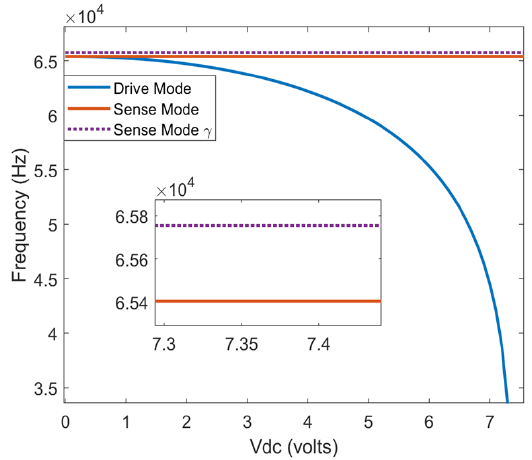
Figure 3. Coupled frequencies of the microgyroscope Ω = 80 rad/s.